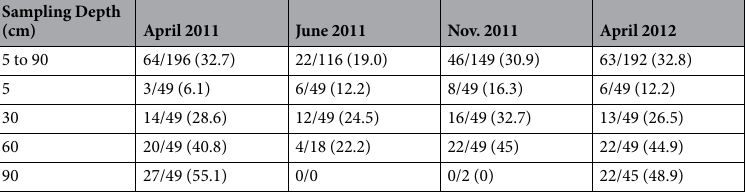
Table 1. Isolation of B. pseudomallei at different soil depths for each sampling round. (Positive samples/Total collected and percentage in